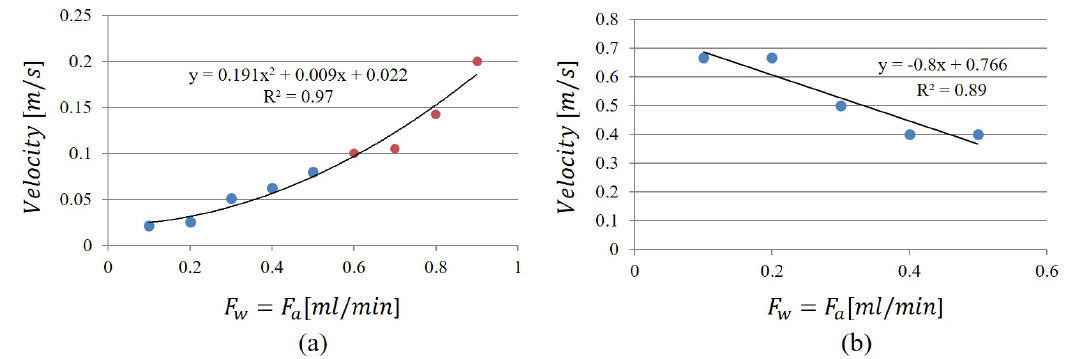
Figure 5. The cross-correlation function was computed for all the nine experiments. ( a ) the values of water velocity obtained by the highest peak were plotted versus the input flow rate: the blue dot are for F ∈ { 0.1,0.2,0.3,0.4,0.5 } mL/min and the red dots for F ∈ { 0.6,0.7,0.8,0.9 } mL/min; ( b ) the values of air velocity, obtained by the second peak for F ∈ { 0.1,0.2,0.3,0.4,0.5 }